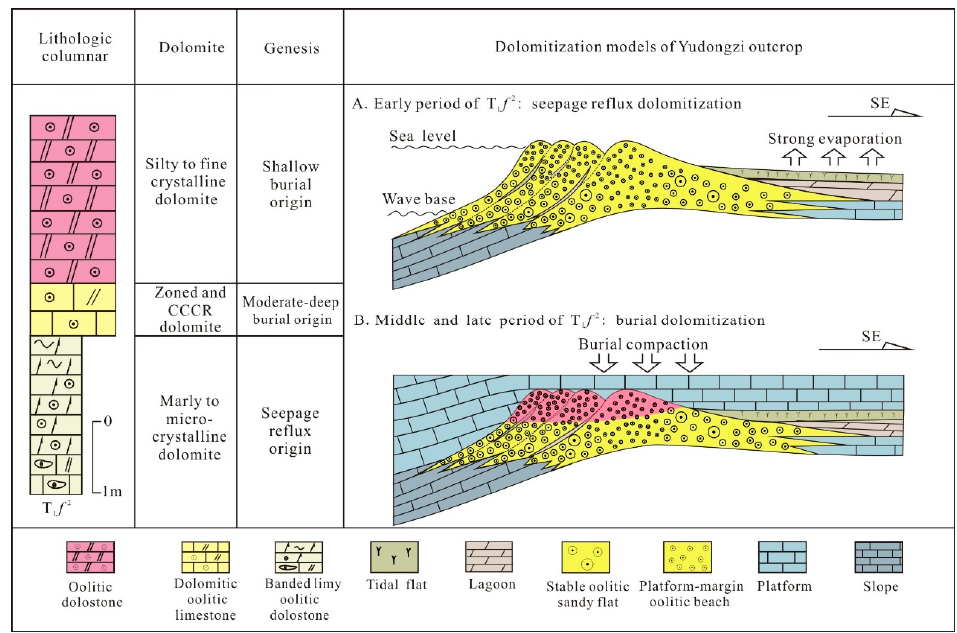
Figure 11. Dolomitization models for rocks of the Yudongzi outcrop.